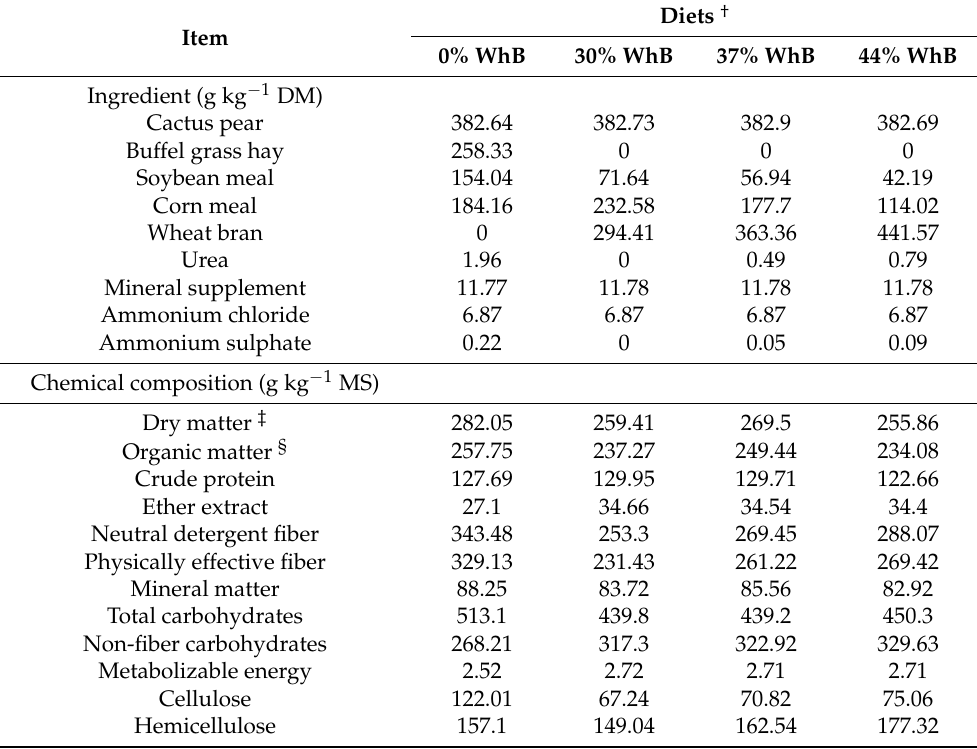
Table 2. Percentage and chemical composition of the experimental diets on a dry matter